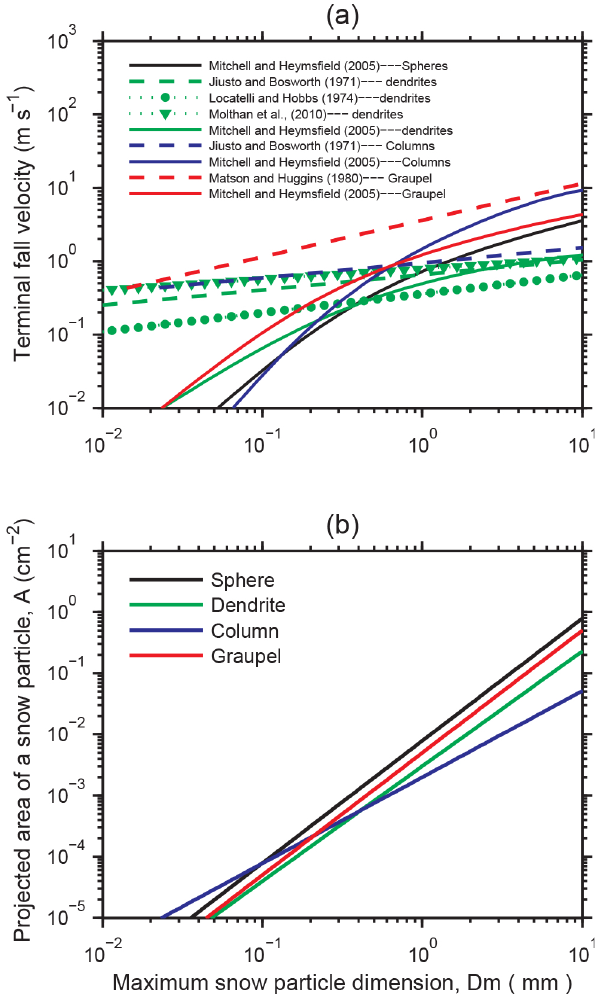
Fig. 5. Snow-particle (a) terminal velocity and (b) cross-sectional area vs. maximum snow-particle dimension derived from different parameterizations (see Tables 3 and